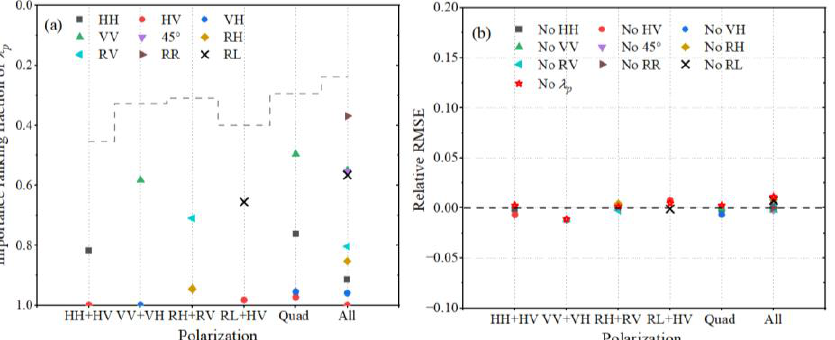
Figure 23. The importance of φ to SWH retrieval from single-polarization models. ( a ) The im- portance ranking of φ provided by XGBoost models normalized to 0 – 1. The dotted line represents the optimal feature sets under different polarizations. ( b ) The effect of removing φ on the SWH estimation from different polarized models. Different markers in various colors represent φ of dif- ferent polarizations. ( c ) The correlation between φ and ERA5 SWH under different polarizations.